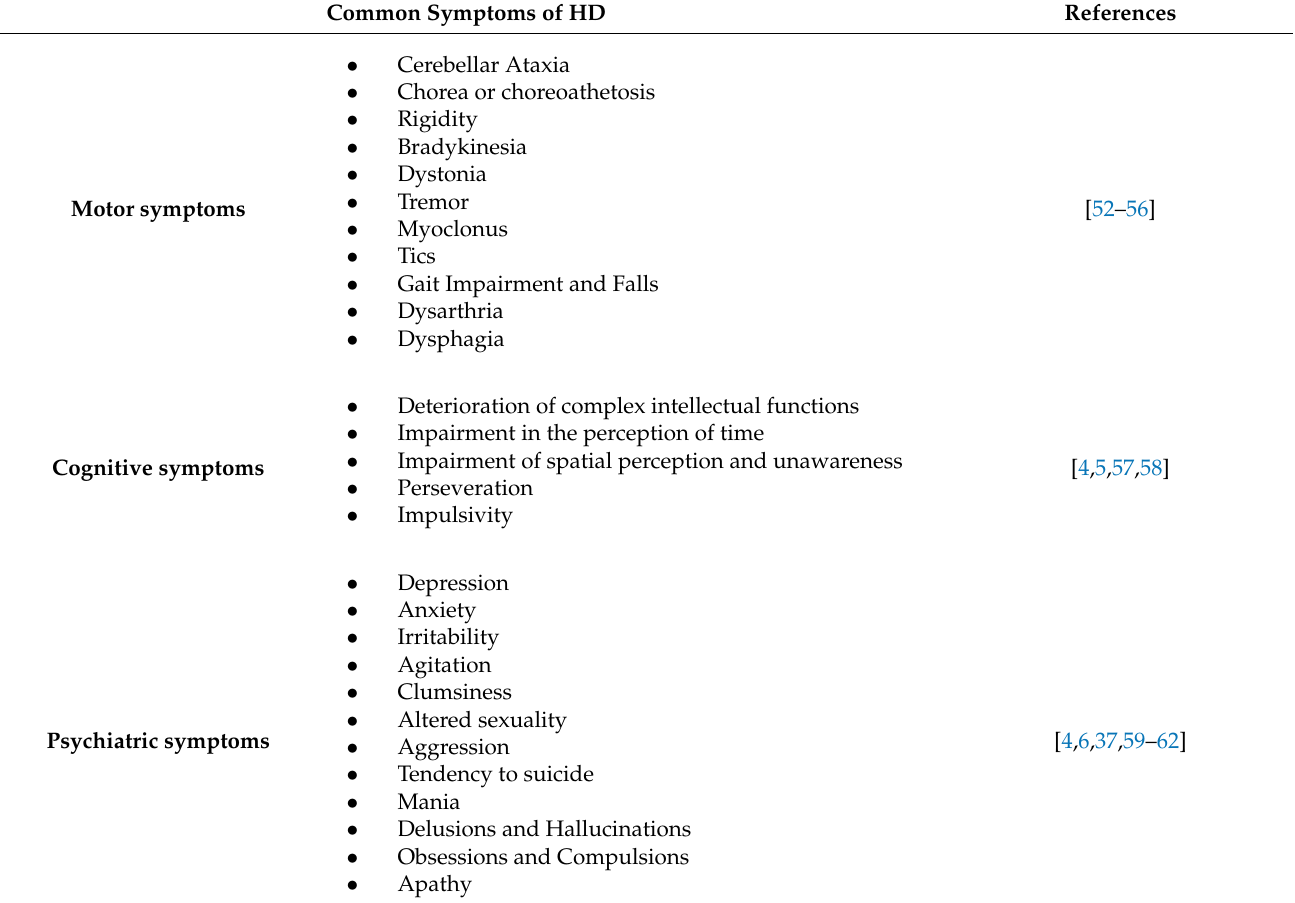
Table 1. Common symptoms of HD. Common Symptoms of